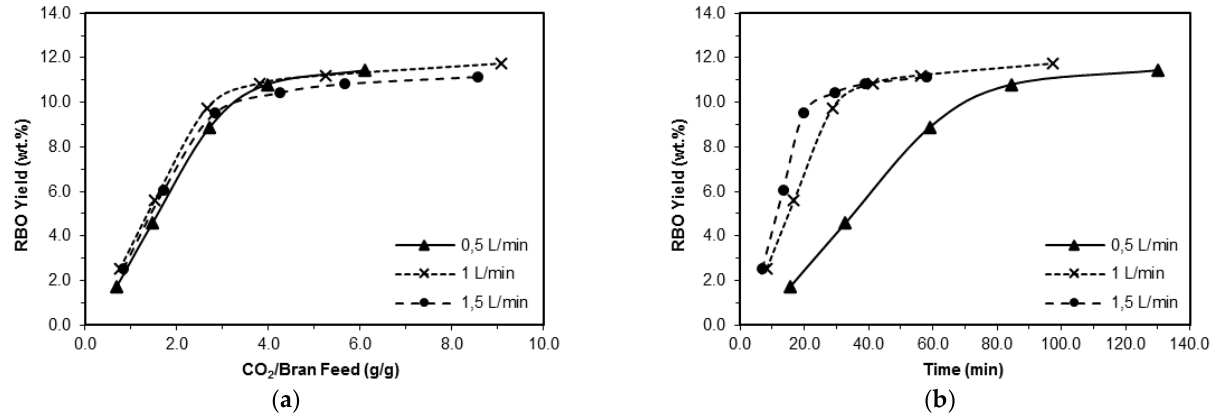
Figure 2. Supercritical fluid extraction yield of rice bran oil as a function of ( a ) consumed CO 2 and ( b ) time for different CO 2 flow rates (at 40 MPa, 313 K, and using 20 g of rice bran loading).